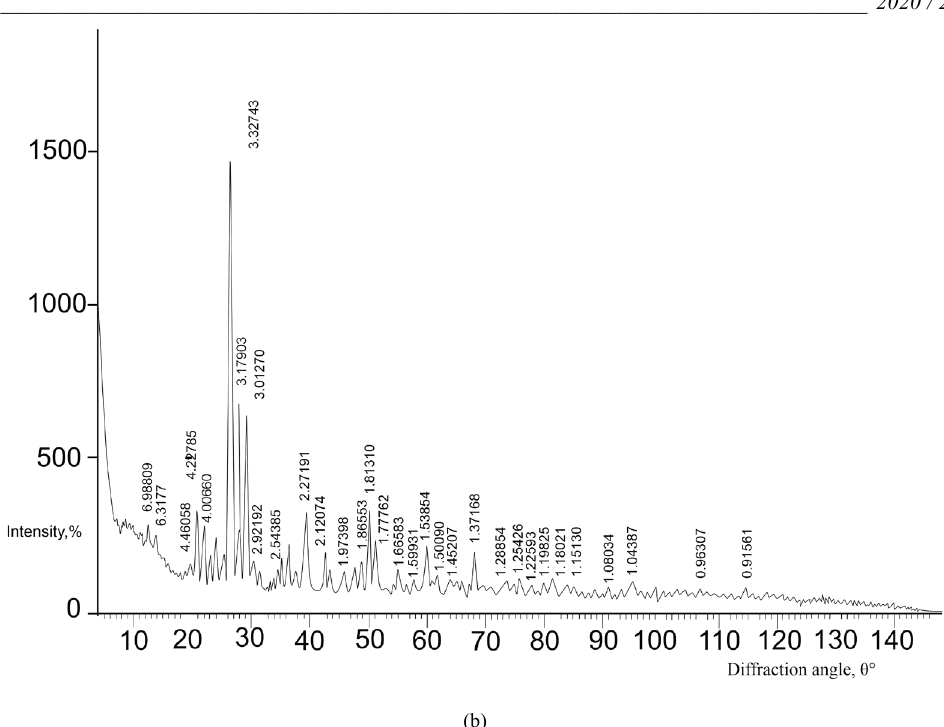
Fig. 6. Radiographs : a) experimental and b) control samples of soil - concrete sludge (with a concrete additive) (XRD)